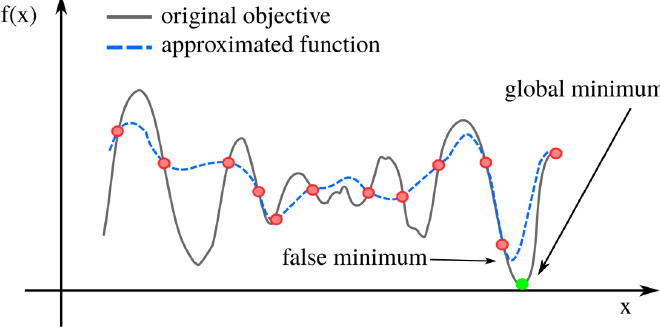
Figure 8. An example of a false minimum in the surrogate